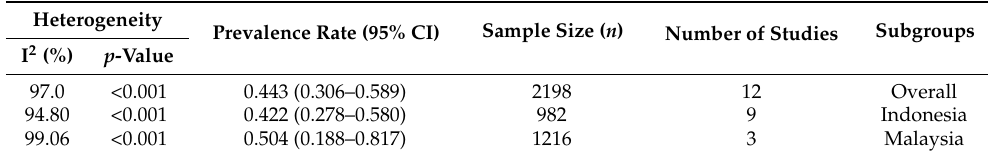
Table 2. The heterogeneity and prevalence rate of insulin resistance in the overall and subgroups of the meta-analysis.